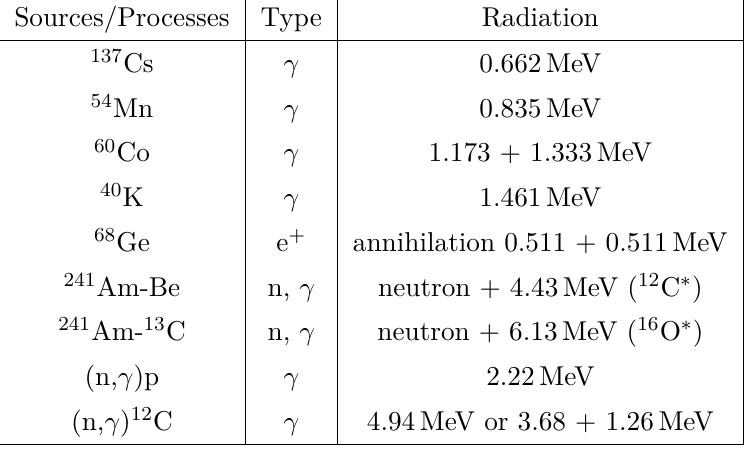
obtained from a separate bench experiment [14]. The optical parameters of the acrylic sphere, ultrapure water and other materials are taken from bench measurements. The quantum efficiency and collection efficiency (angle-dependent) of the LPMTs are initially set at the average value from quality assurance tests and can be adjusted individually in the simulation. The “low energy Livermore model”, which incorporates atomic shell cross section data [15], is selected as the electromagnetic interaction model in